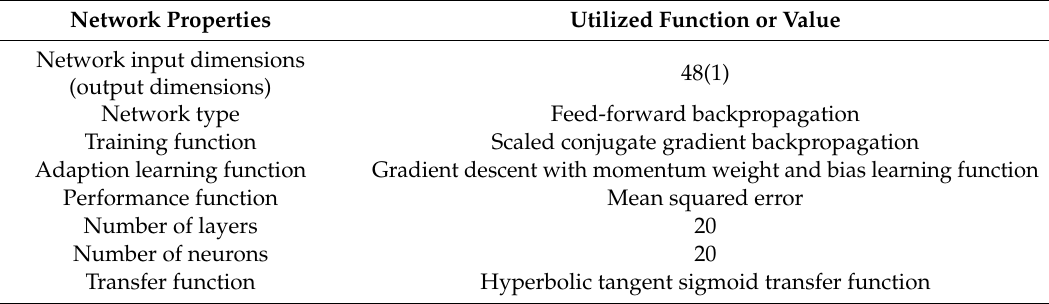
Table 2. Neural network construction for surrogate